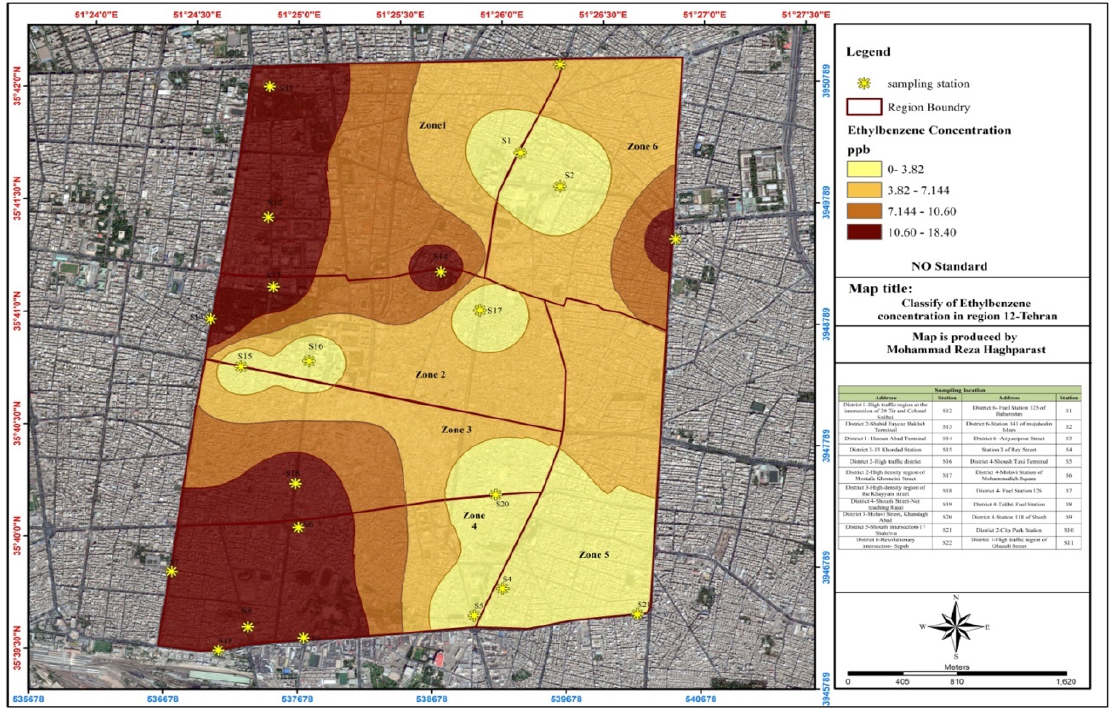
Figure 10. Zoning Ethyl Benzene concentration in the region on January, 2018